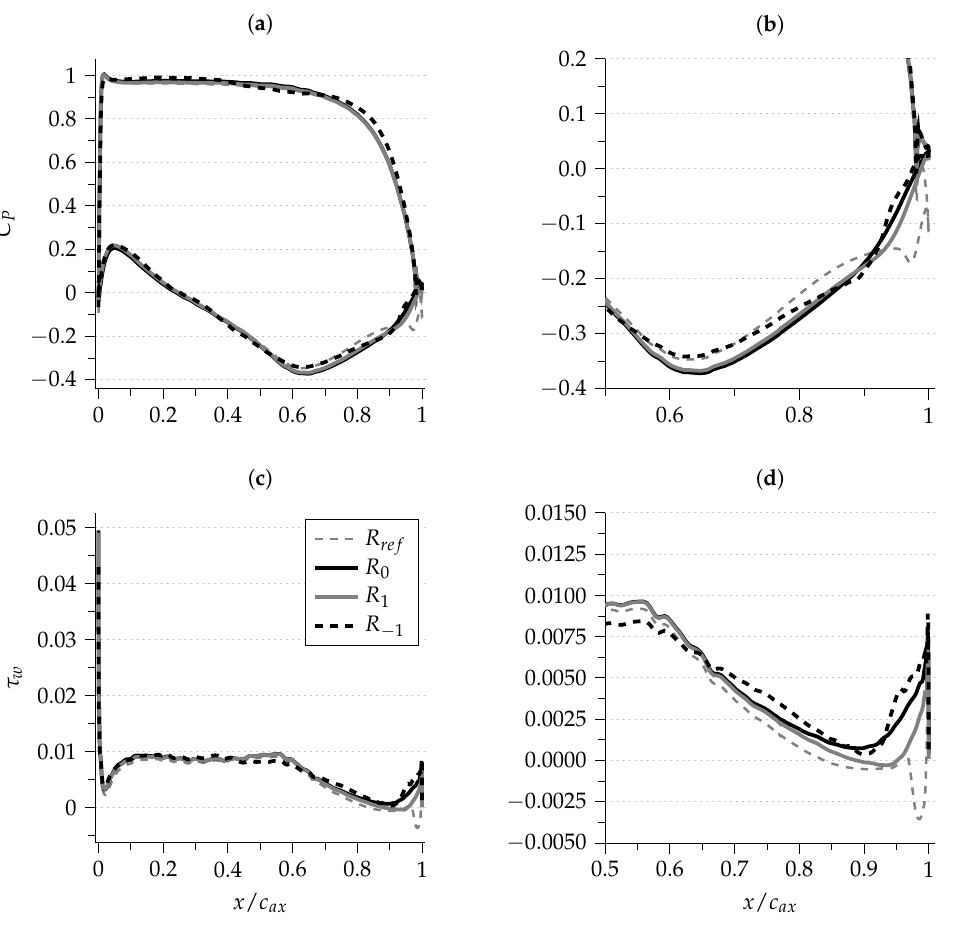
Figure 4. Comparison of the time-averaged pressure coefficient C P ( a , b ) and the wall shear stress τ w ( c , d ) for the four cases. With the non-rotating bar case R 0 , the counter-clockwise rotating bar case R 1 , the clockwise rotating bar case R − 1 and the reference case R ref without